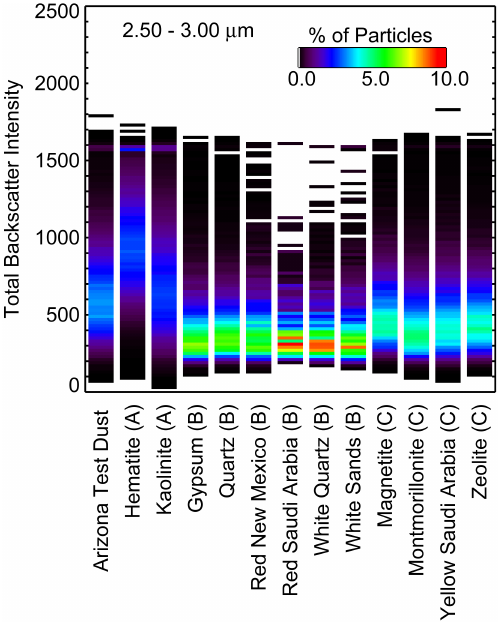
Fig. 6. For the 2.5 to 3.0µm CASPOL channel, the percentages of particles which have a given total backscatter intensity are shown for each dust